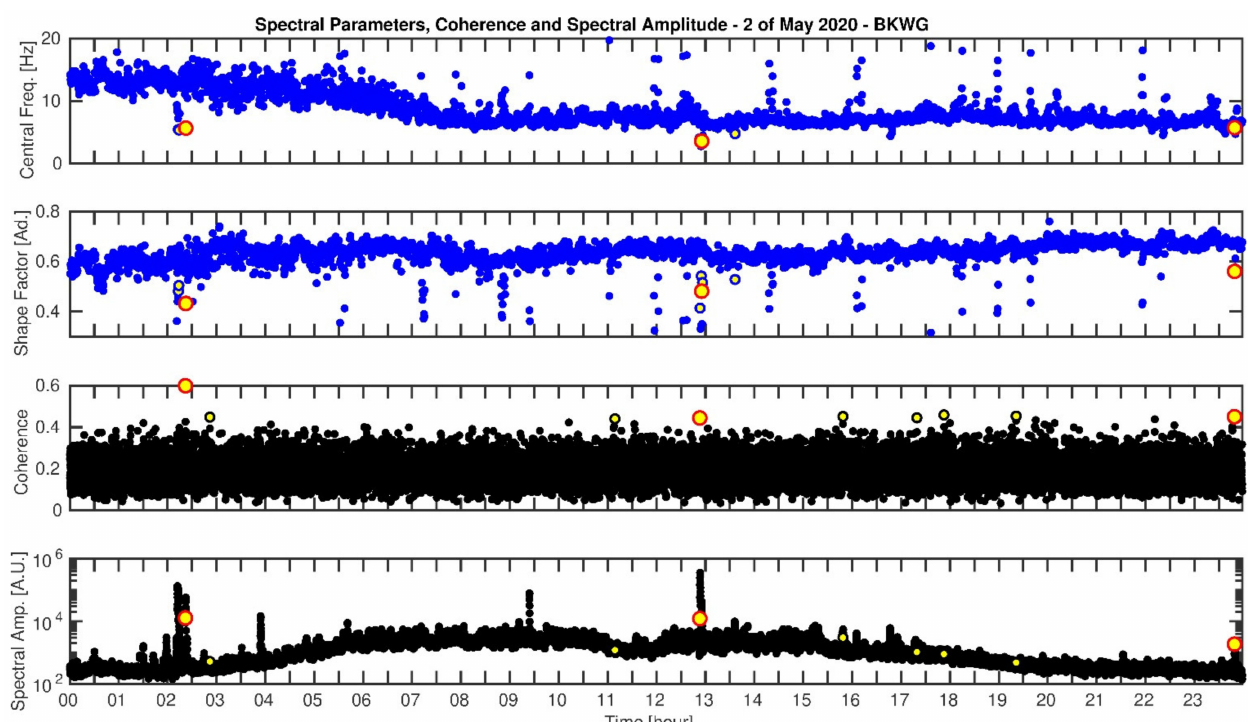
Figure 4. Central frequency, shape factor, coherence and average spectral amplitude versus time for the signals recorded on 2 May 2020. Central frequency and shape factor (blue circles) are shown only for BKWG station. Coherence and average spectral amplitude (black circles) were evaluated and focused at 4 Hz for the signals recorded at BKWG, BKSG and SVAG. The yellow circles identify the signal windows that satisfy the features of LF events. Small yellow circles mark windows for which only one condition between spectral features (yellow and blue circles) and coherence threshold (yellow and black circles) is satisfied. Larger yellow circles with red border show the windows that satisfy all the characteristics (spectral features and coherence) of LF